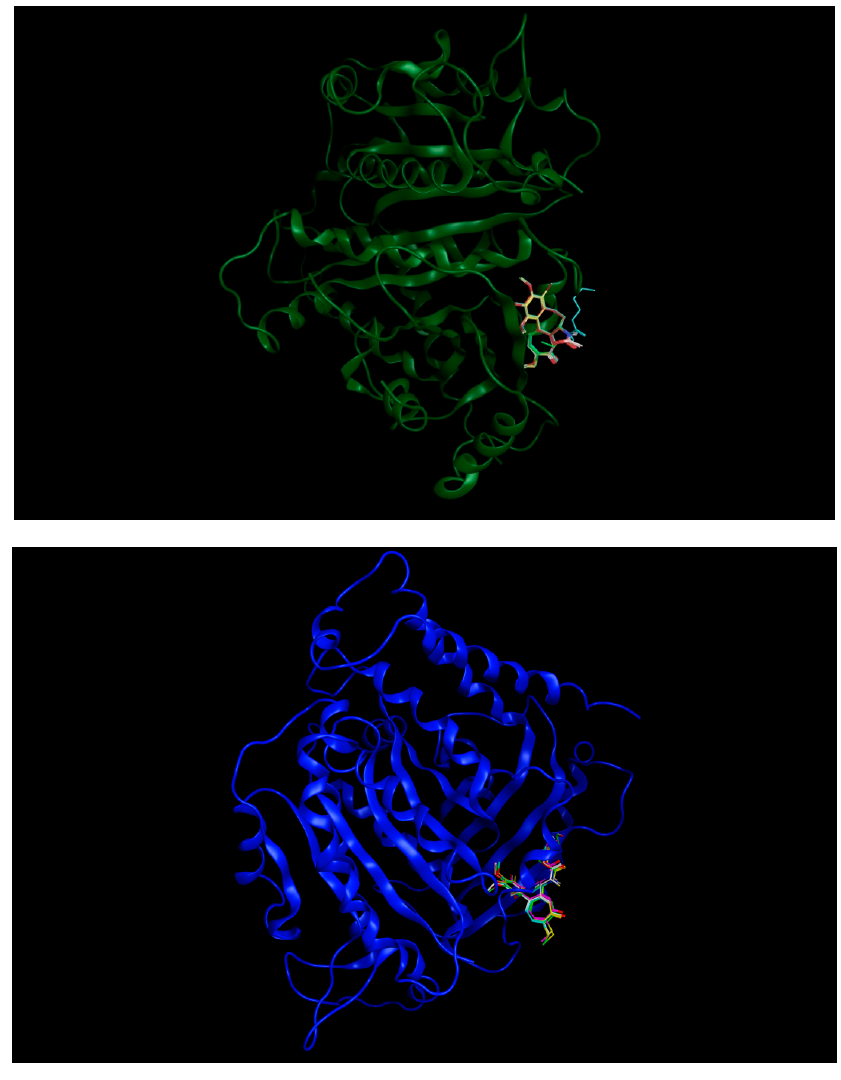
Figure 13. Tubulin β I structure in 3D with ( Top ) 5 colchicine derivatives with binding energies of − 8.40 kcal/mol and higher, and ( Bottom ) with 6 colchicine derivatives with binding energies lower than − 8.40 kcal/mol.